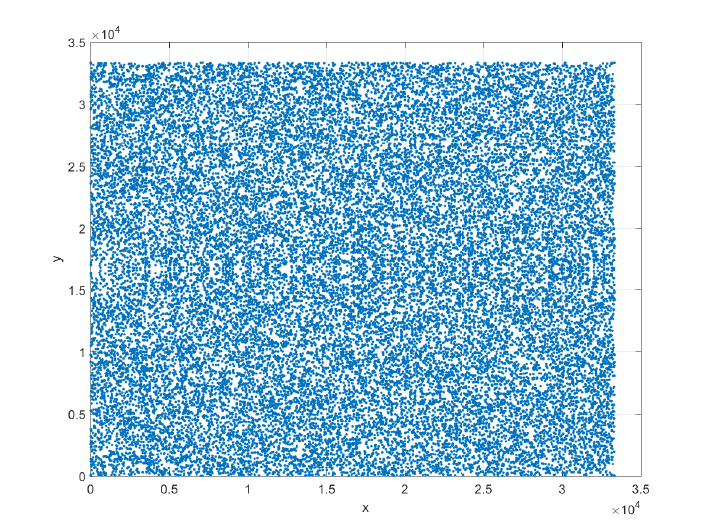
Figure 1. Distribution of points on an elliptic